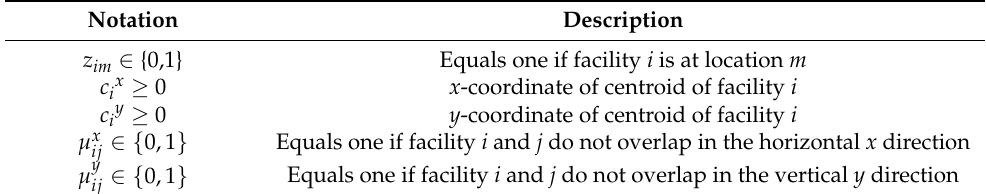
Table A3. Decision variables employed in the MIP